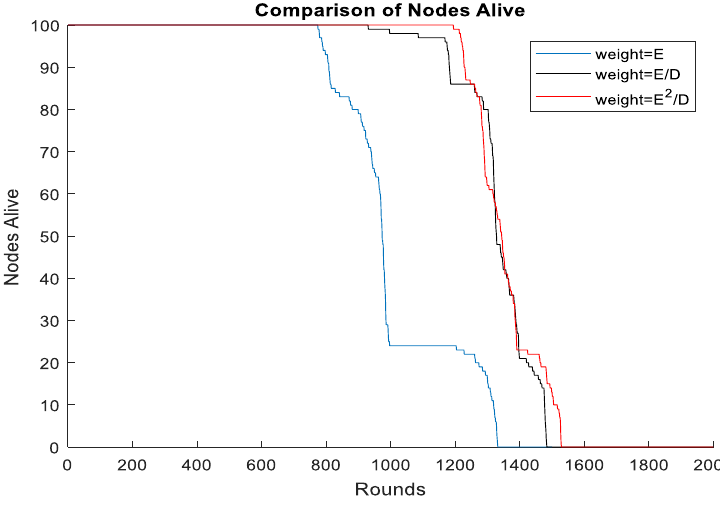
Figure 12. Different methods of weight calculation.